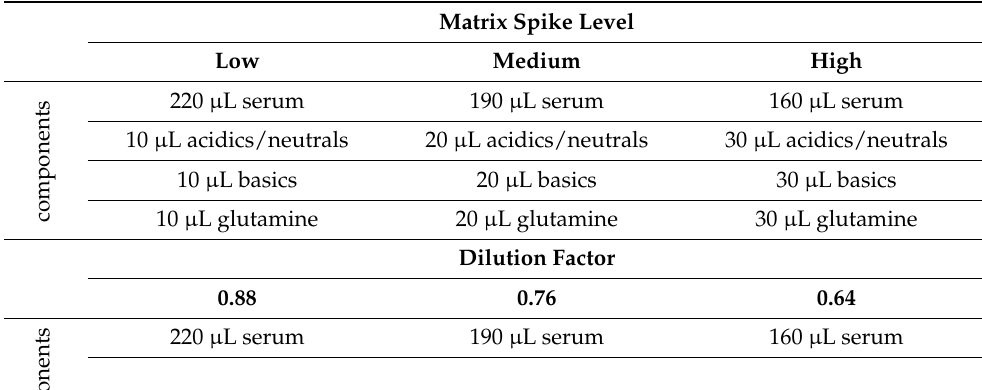
Table 1. The components used to make the spiked matrix samples and diluted matrix